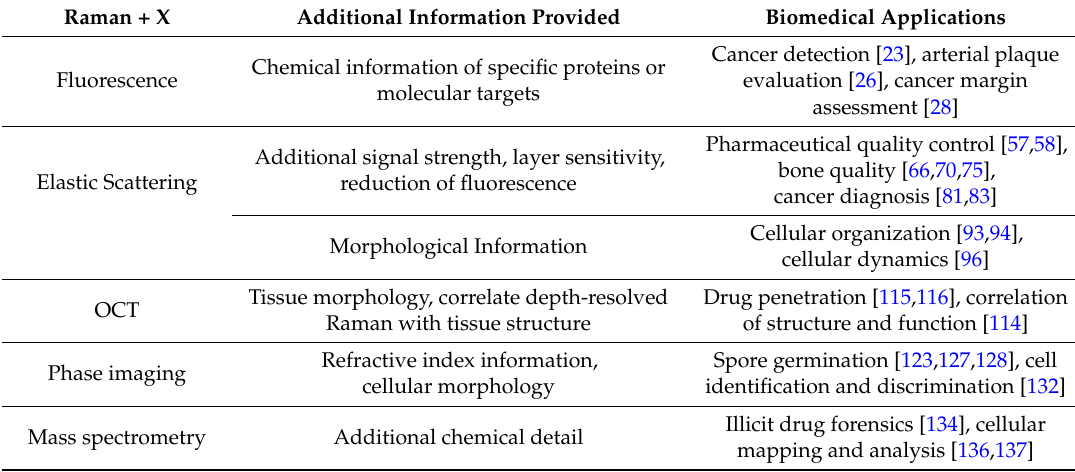
Table 1. Overview of multimodal Raman